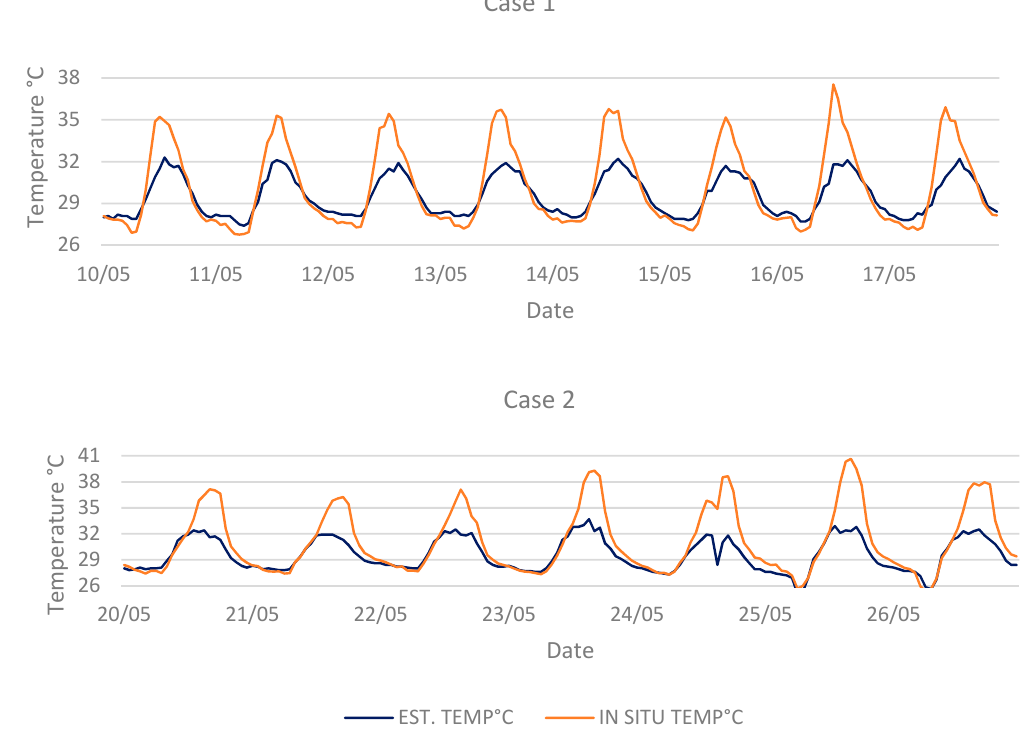
Figure 4. Graphical comparison between macro-environment (est. temp. °C) and micro-environment (in situ temp. °C) data in a week period. Above, Case 1; below, Case 2. Table 5. Comparison between macro-environment data and micro-environment data